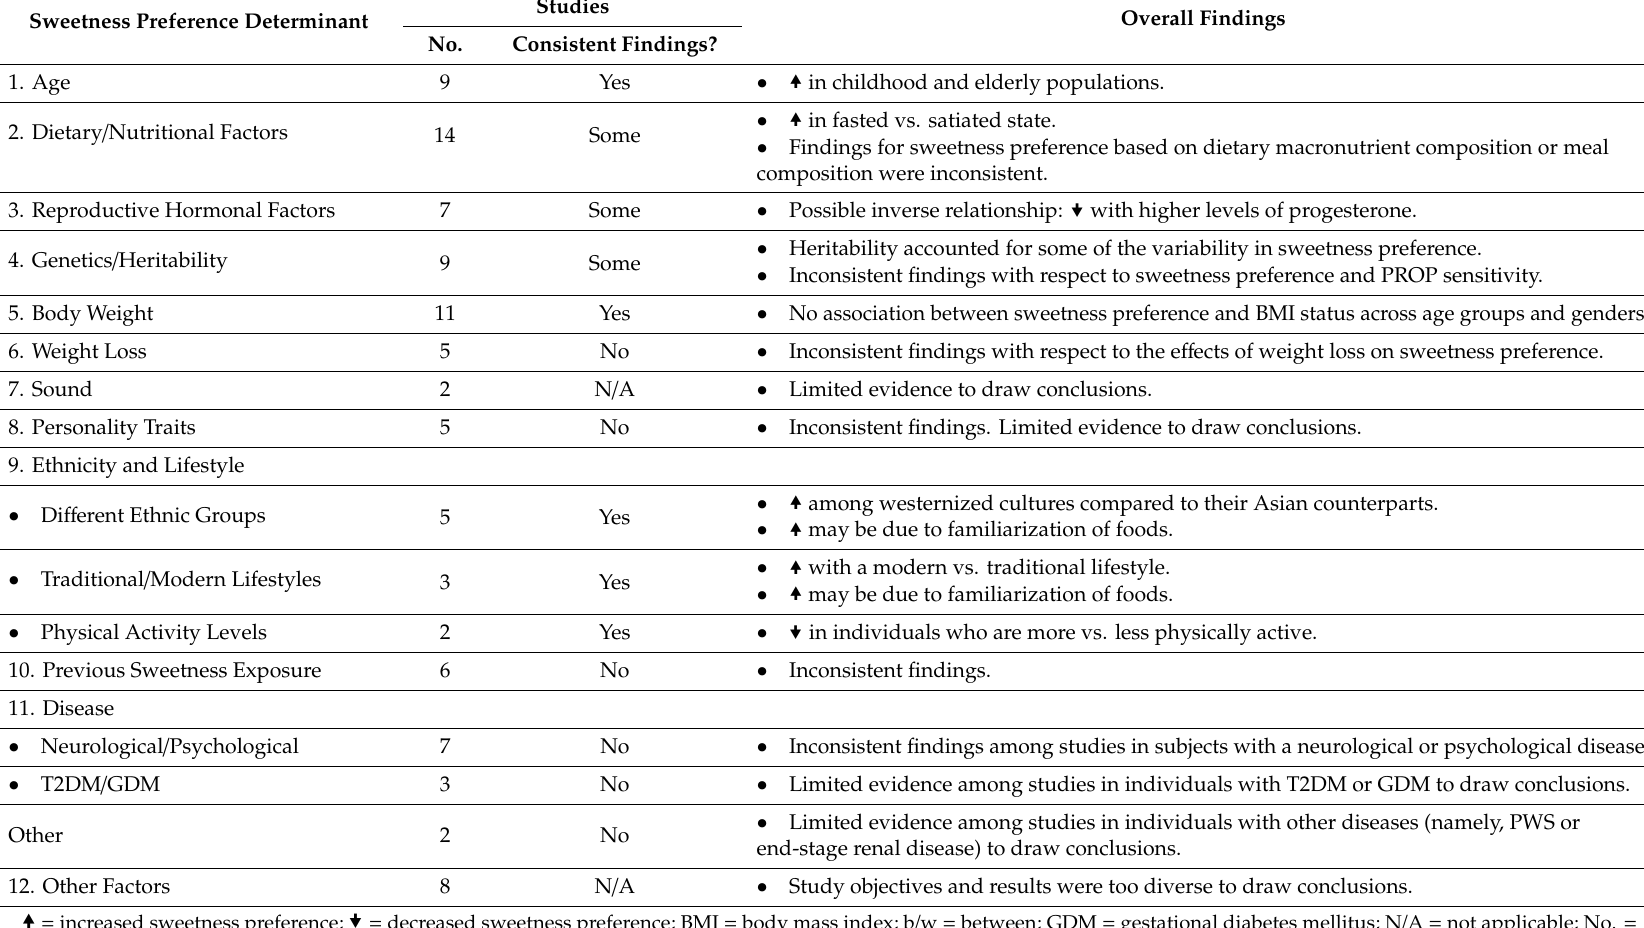
Table 2. Summary of findings: E ff ects of identified determinants on sweetness preference. Table 2. Summary of findings: Effects of identified determinants on sweetness preference. Table 2. Summary of findings: Effects of identified determinants on sweetness preference. Table 2. Summary of findings: Effects of identified determinants on sweetness preference.